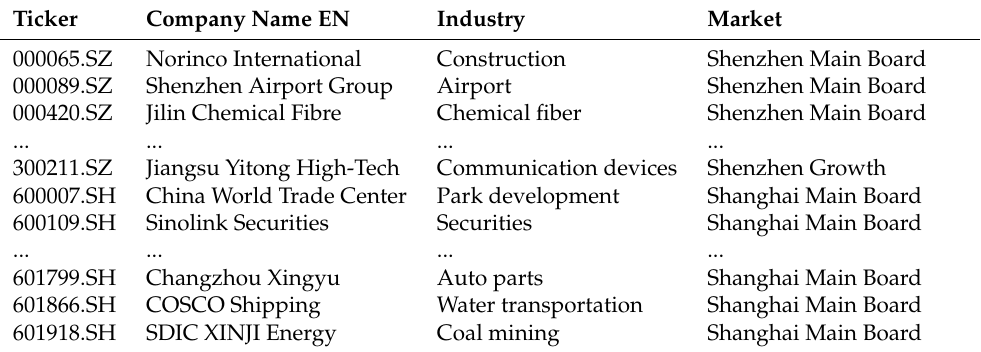
Table A4. Details of some example companies among the portfolio of 100